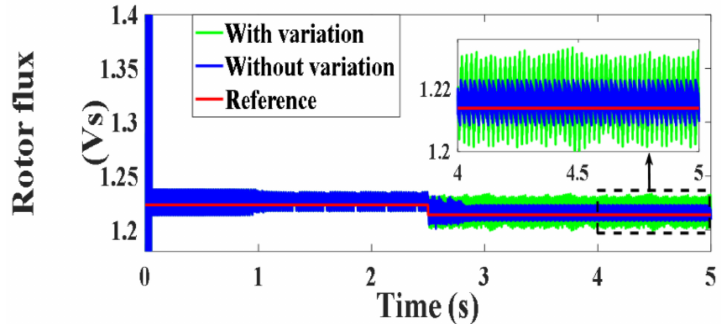
Figure 148. Rotor flux under PVC (Vs).